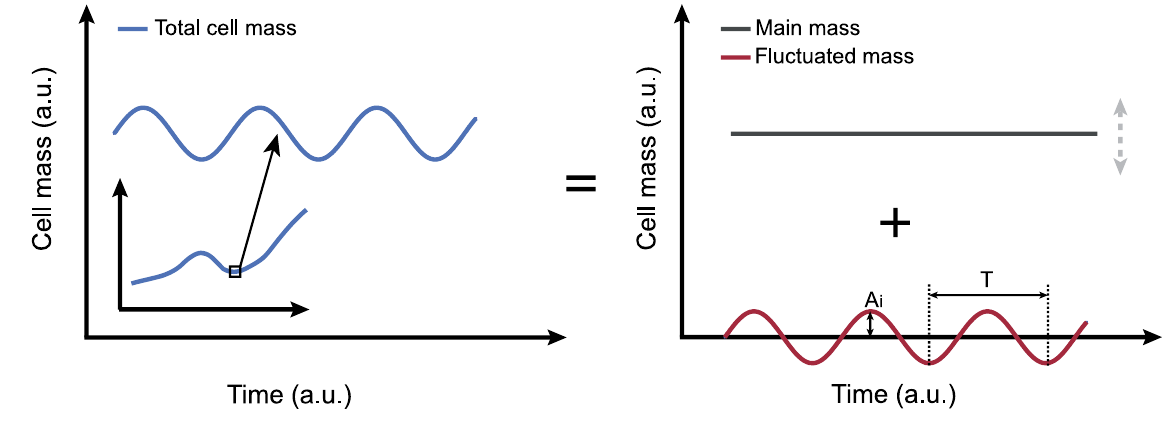
Figure 2 Fast fluctuations of a cell’s mass. The inset (left plot) illustrates the dynamics of a cell’s total mass over an extended period of time (~ hours). The left plot corresponds to a zoom in of the previous inset in which fluctuations of a cell’s mass are visible over a span of tens of seconds. As depicted in the right plot, the fluctuations can be decomposed into two components: the fluctuated mass, which shows certain periodicity (T) and amplitude (Ai), and the main mass. The latter may also vary over time as shown by the grey arrow (right plot), yet at much slower rate than the fast fluctuated mass (timescale of seconds). Thus, it can be considered largely constant for the e ff ects analysed